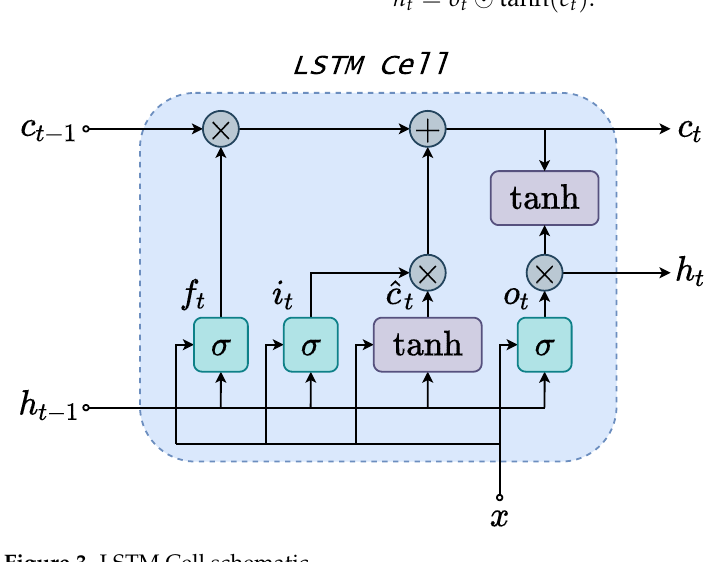
Figure 3. LSTM Cell